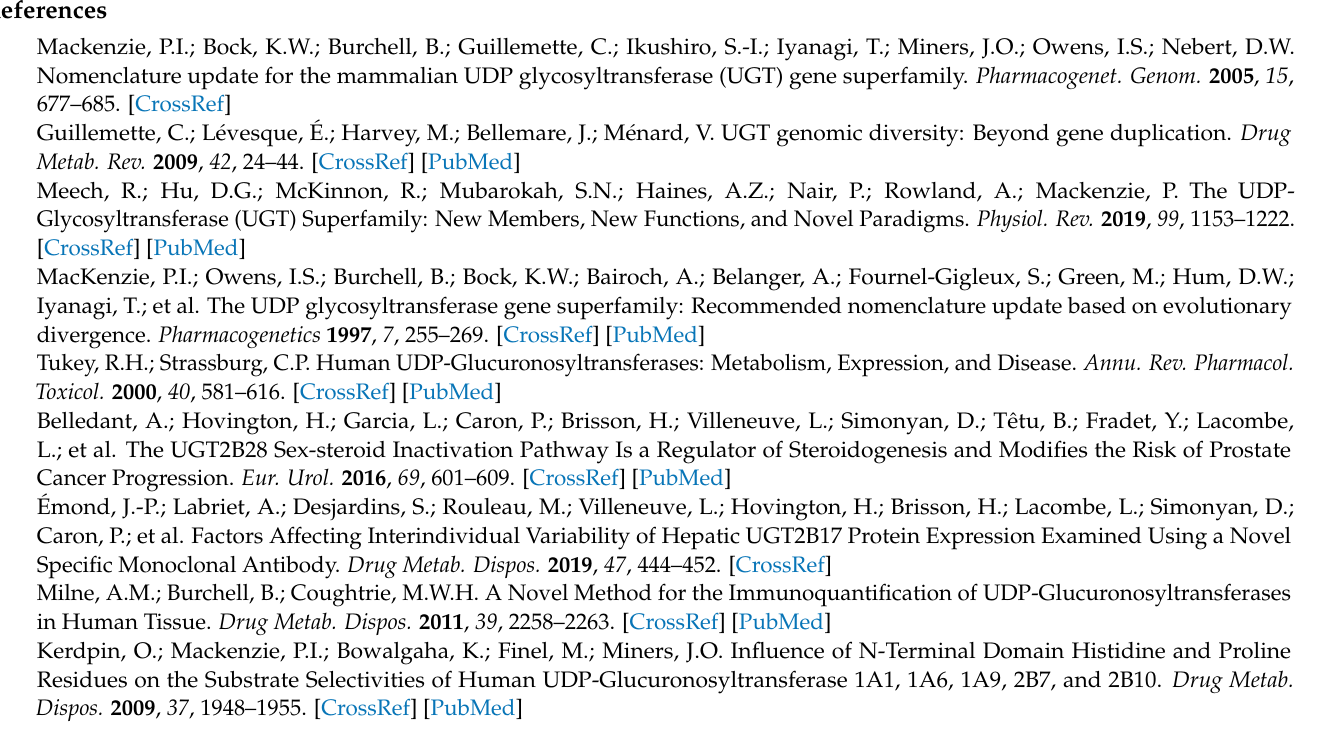
TCGA cancers; Figure S2: The expression profiles of UGT genes in 17 different types of TCGA cancers; Figure S3: The expression profiles of 12 UGT genes in 33 different types of TCGA cancers; Figure S4: The expression profiles of UGT3A genes in 33 different types of TCGA cancers; Figure S5: Expression of UGT genes in matched cancerous (T) and adjacent non-cancerous (N) tissues in 8 different TCGA cancer types; Table S1: The expression levels (normalized RSEM values) of UGT genes and clinical datasets of 9514 patients from 33 different types of TCGA cancers; Table S2: The expression levels (means, medians, standard deviations) of UGT genes and assessment of their associations with overall survival rates in 33 different TCGA cancer types; Table S3: HT-seq counts for UGT genes in matched tumor and adjacent non-cancerous tissues for 611 patients from 12 different TCGA cancer types; Table S4: Differential gene expression analysis of 611 patients from 12 TCGA cancer types using DESeq2 revealed the UGT genes that were deregulated in these cancers; Table S5: Drug regimens of 7 TCGA cancer